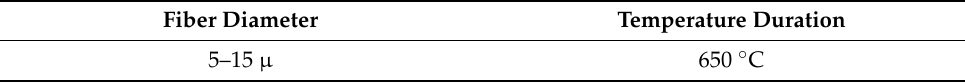
Table 3. The physical properties of the glass